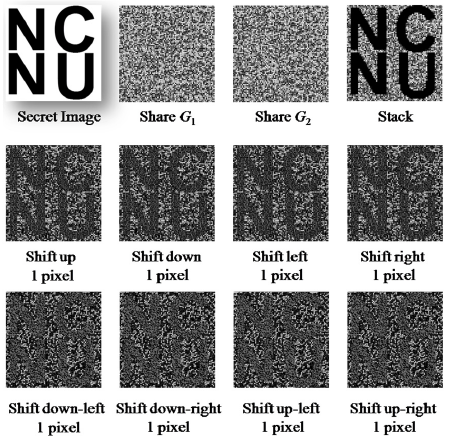
Figure 5. The experimental results for n = 4. Appl. Sci. 2016 , 6 , 18